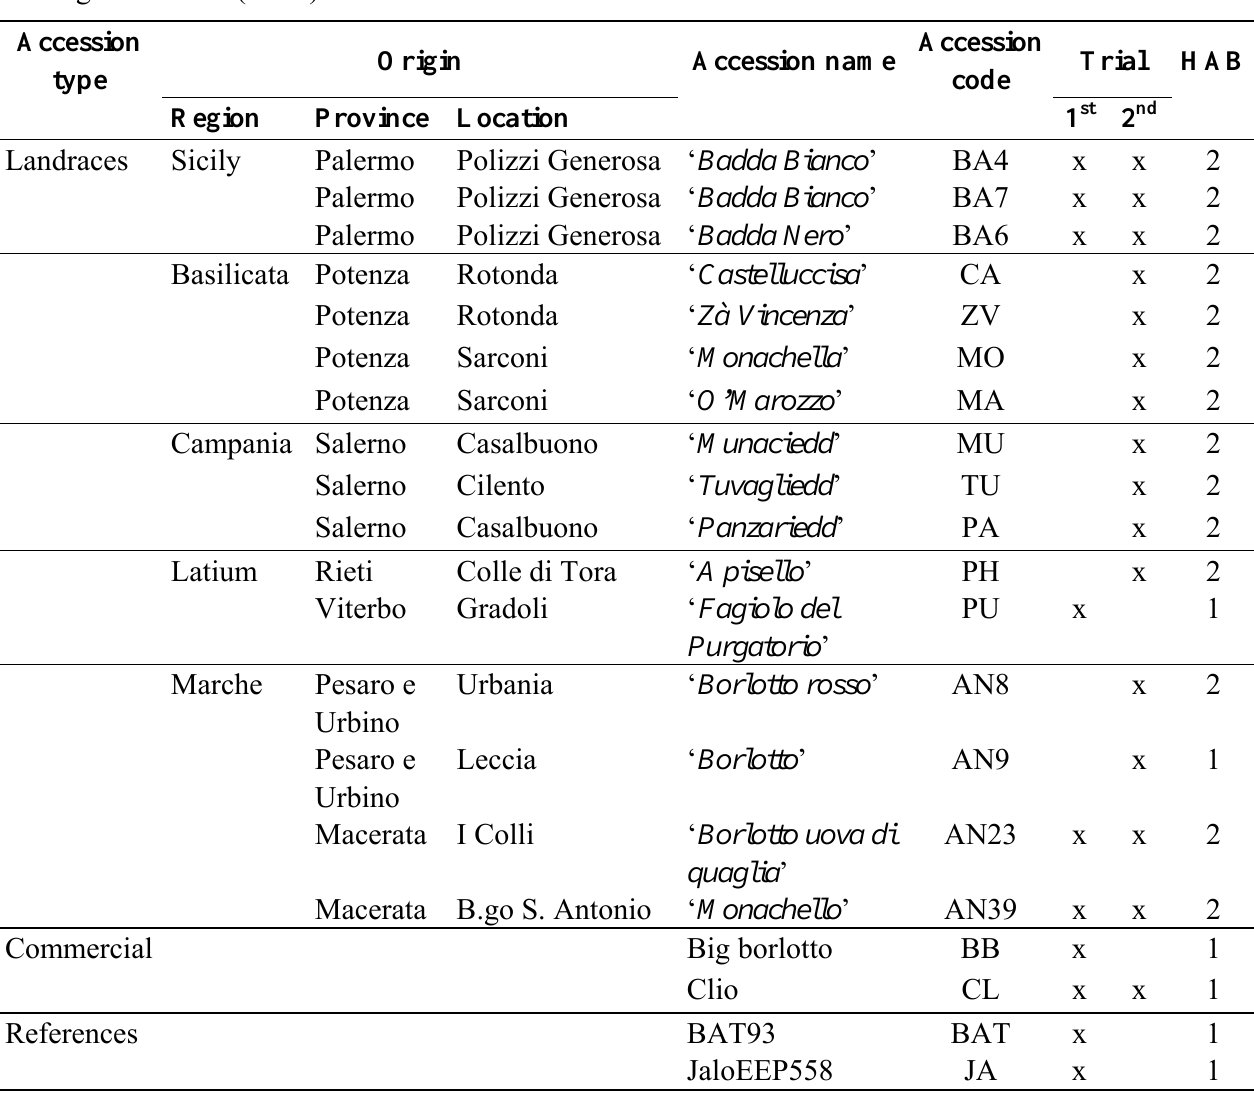
Table 1. List of the landraces and cultivars included in the trials, their origin, codes and growth habit